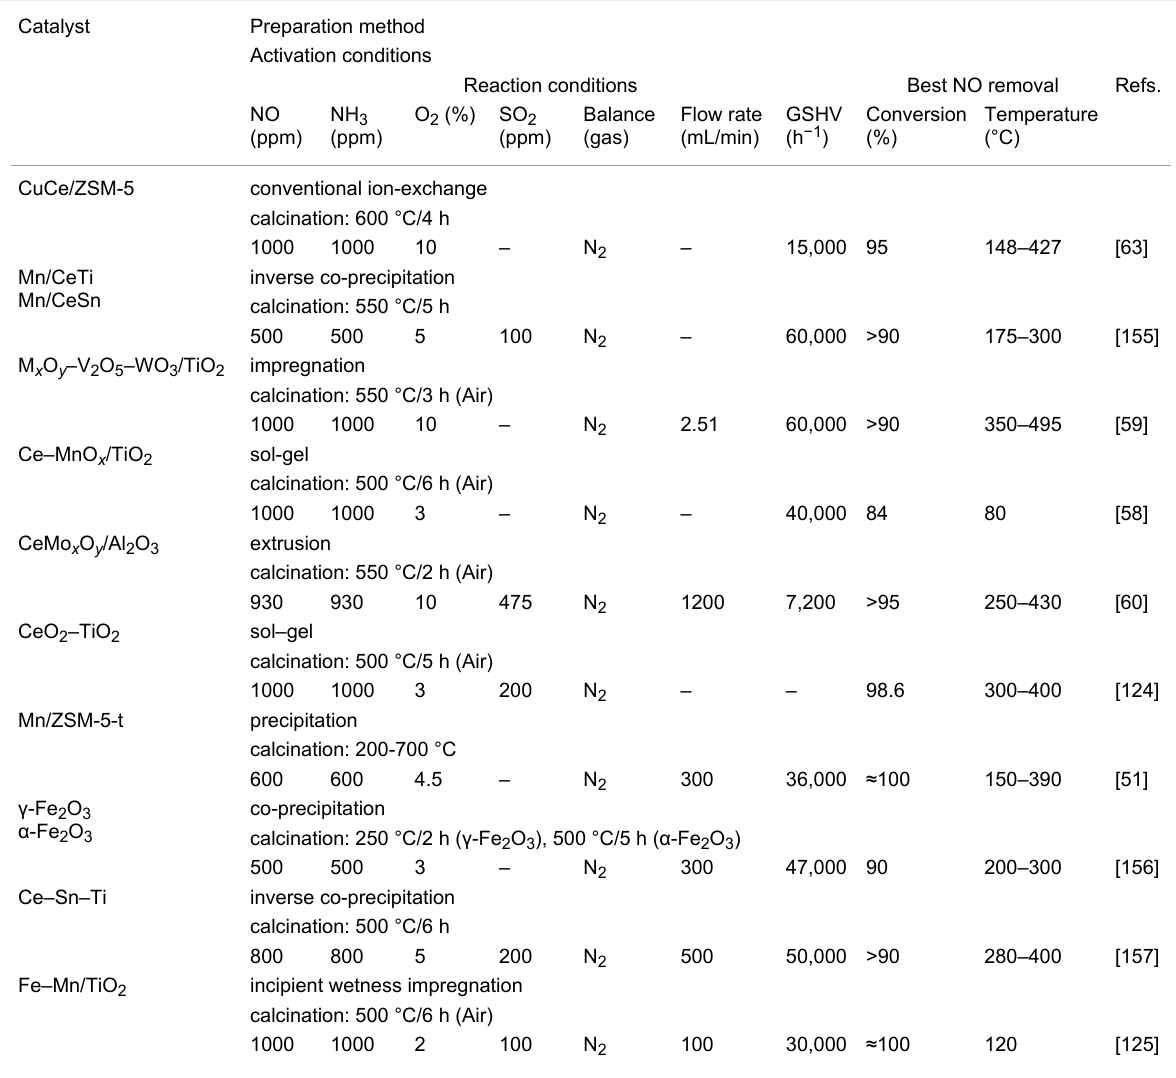
Table 5: Summary on the reaction conditions and NO activity for non-carbon supported